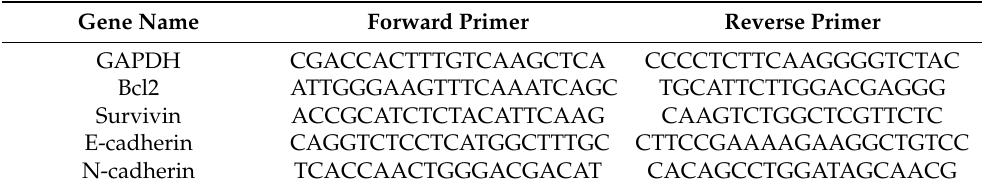
Table 2. List of primers (forward and reverse) used in the present